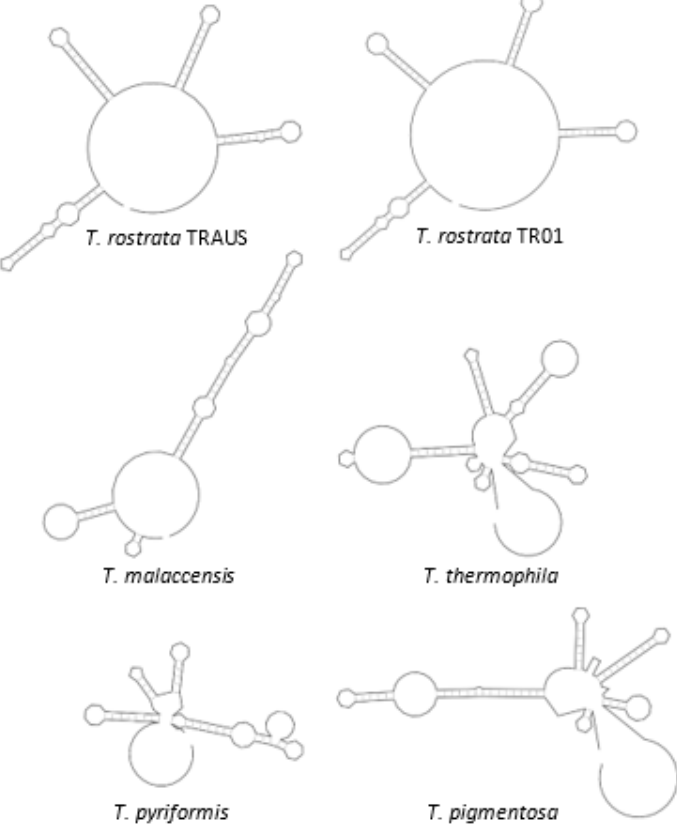
Figure 5. Secondary structures of the central repeat region of T. rostrata TR01 and TRAUS and other Tetrahymena species based on single stranded DNA. Table 3. Comparison of HCE sequences in between ymf 77 and cob in Tetrahymena species.